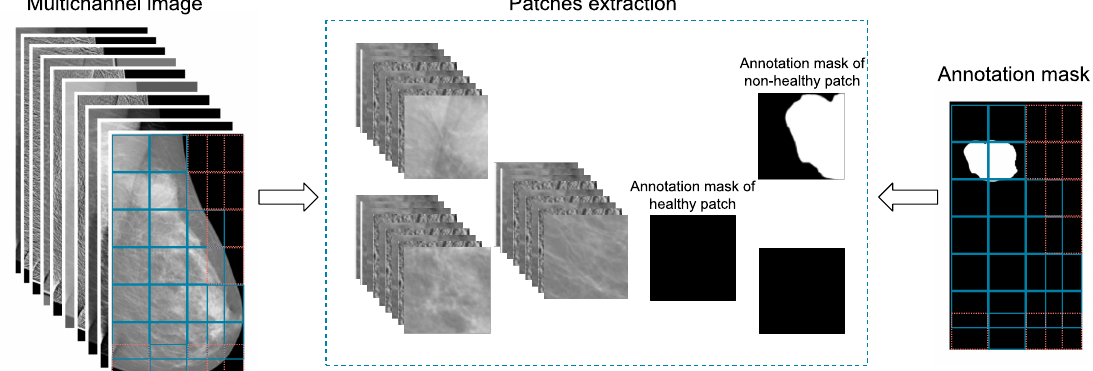
retrieved from the enriched, multichannel image object. The relevant areas are extracted from the corresponding annotation